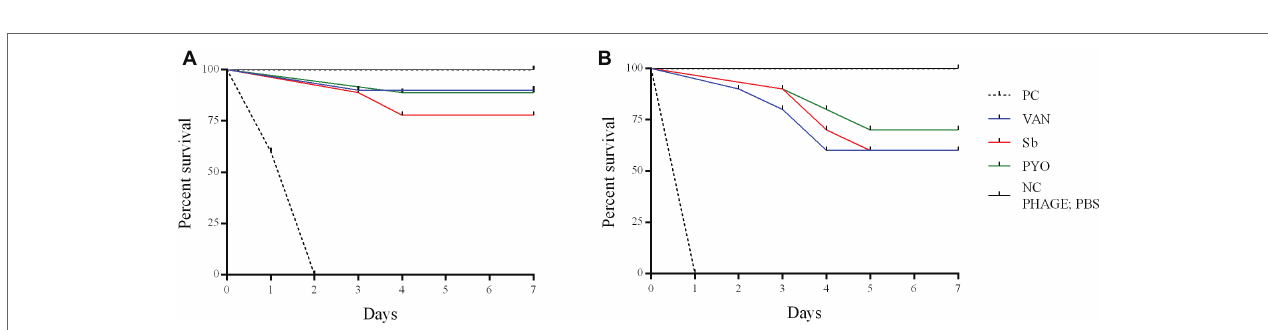
FIGURE 11 | Impact of single phage and vancomycin doses on treatment of MRSA infection and survival rates of G. mellonella larvae . A single phage dose (10 5 PFU/ml) was injected 1 h before the larvae was infected with (A) 2.5–5 × 10 6 CFU/ml (B) 2.5–5 × 10 7 CFU/ml of bacteria. PC, untreated control; NC, non-manipulated; PBS, phosphate-buffered